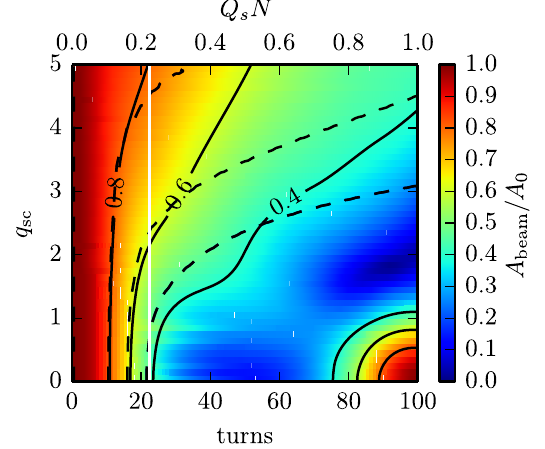
9. Decoherence in bunches with space charge. Colors and solid lines are from simulations for bunches. Dashed contour lines are given by Eq. (17). The vertical white line 22 . 5 turns [Eq. (8)]. Simulation parameters: q is N dec 0 ¼ 0 . 01 A 0 ¼ σ 0 , Q s ¼